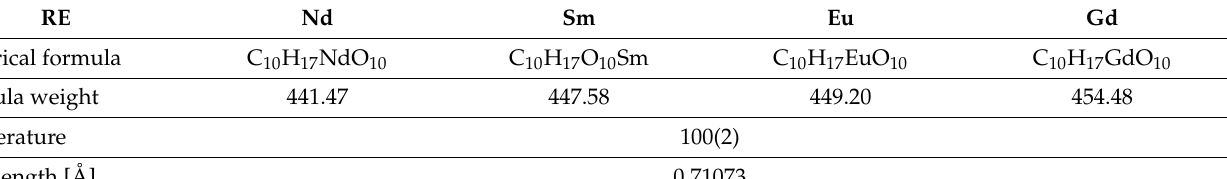
Table 1. Summarized collection on the crystallographic data, data collection and structure refinement of RE(OAc) 3 ·